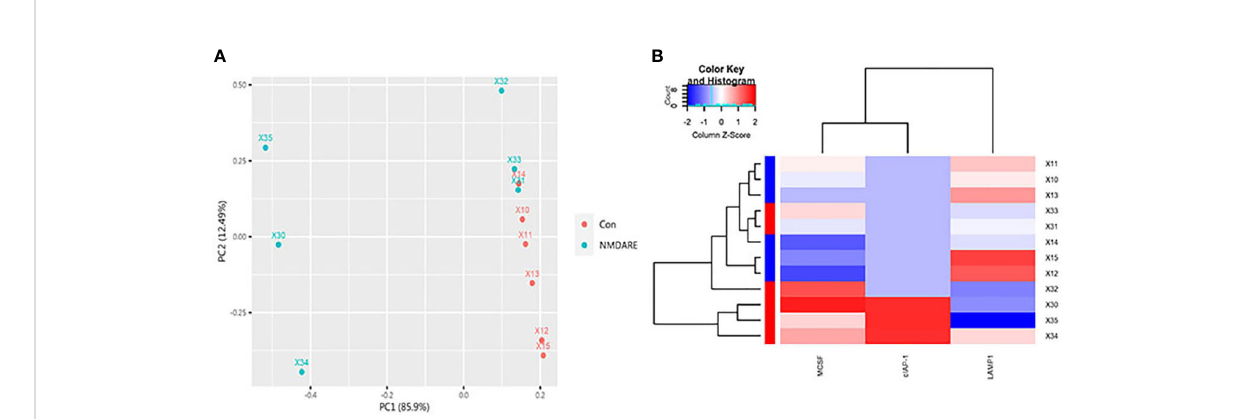
FIGURE 2 PCA and Hierarchical cluster analysis. (A) The array data of the differential proteins were analyzed via PCA. The two principal components are plotted to show the differences between the groups (control group in red and anti-NMDAR encephalitis group in blue). (B) Hierarchical cluster analysis exactly distinguished the anti-NMDAR encephalitis group from the control group. Each column is a protein, from left to right on the abscissa: MCSF, cIAP-1, and LAMP-1. Each row is a patient. Blue indicates low protein levels, white indicates median levels, and red denotes high